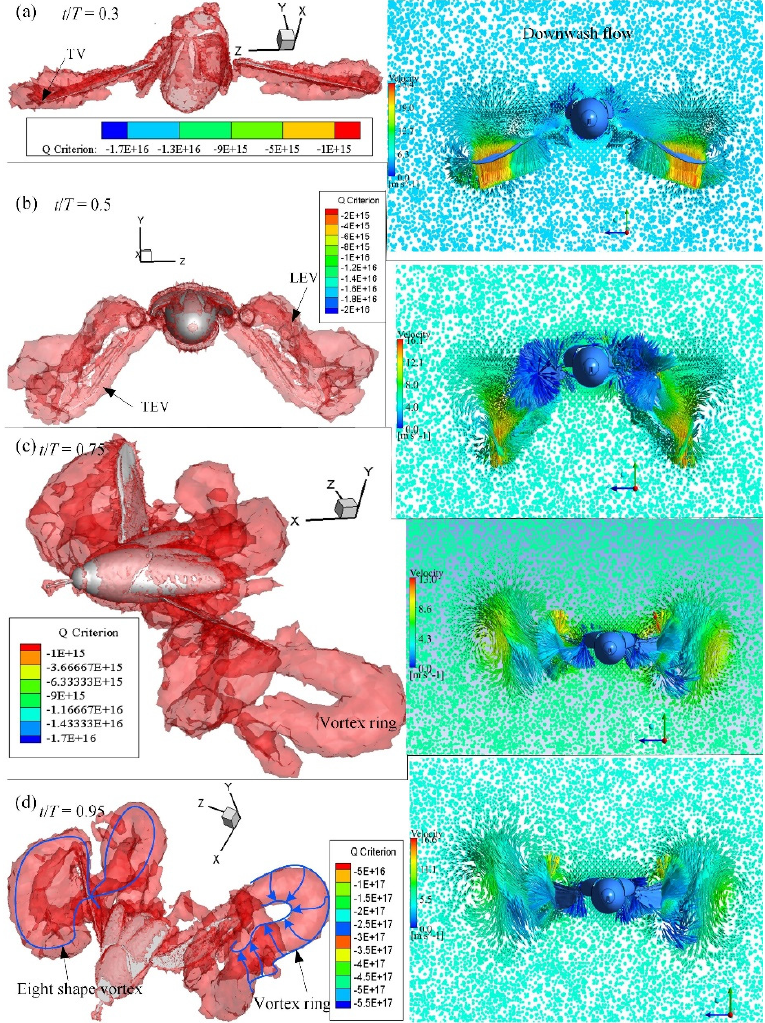
Figure 5. Isometric views of the Q-criterion ( left column ) and downwash velocity ( right column ) on the wing’s surface at some typical time steps.